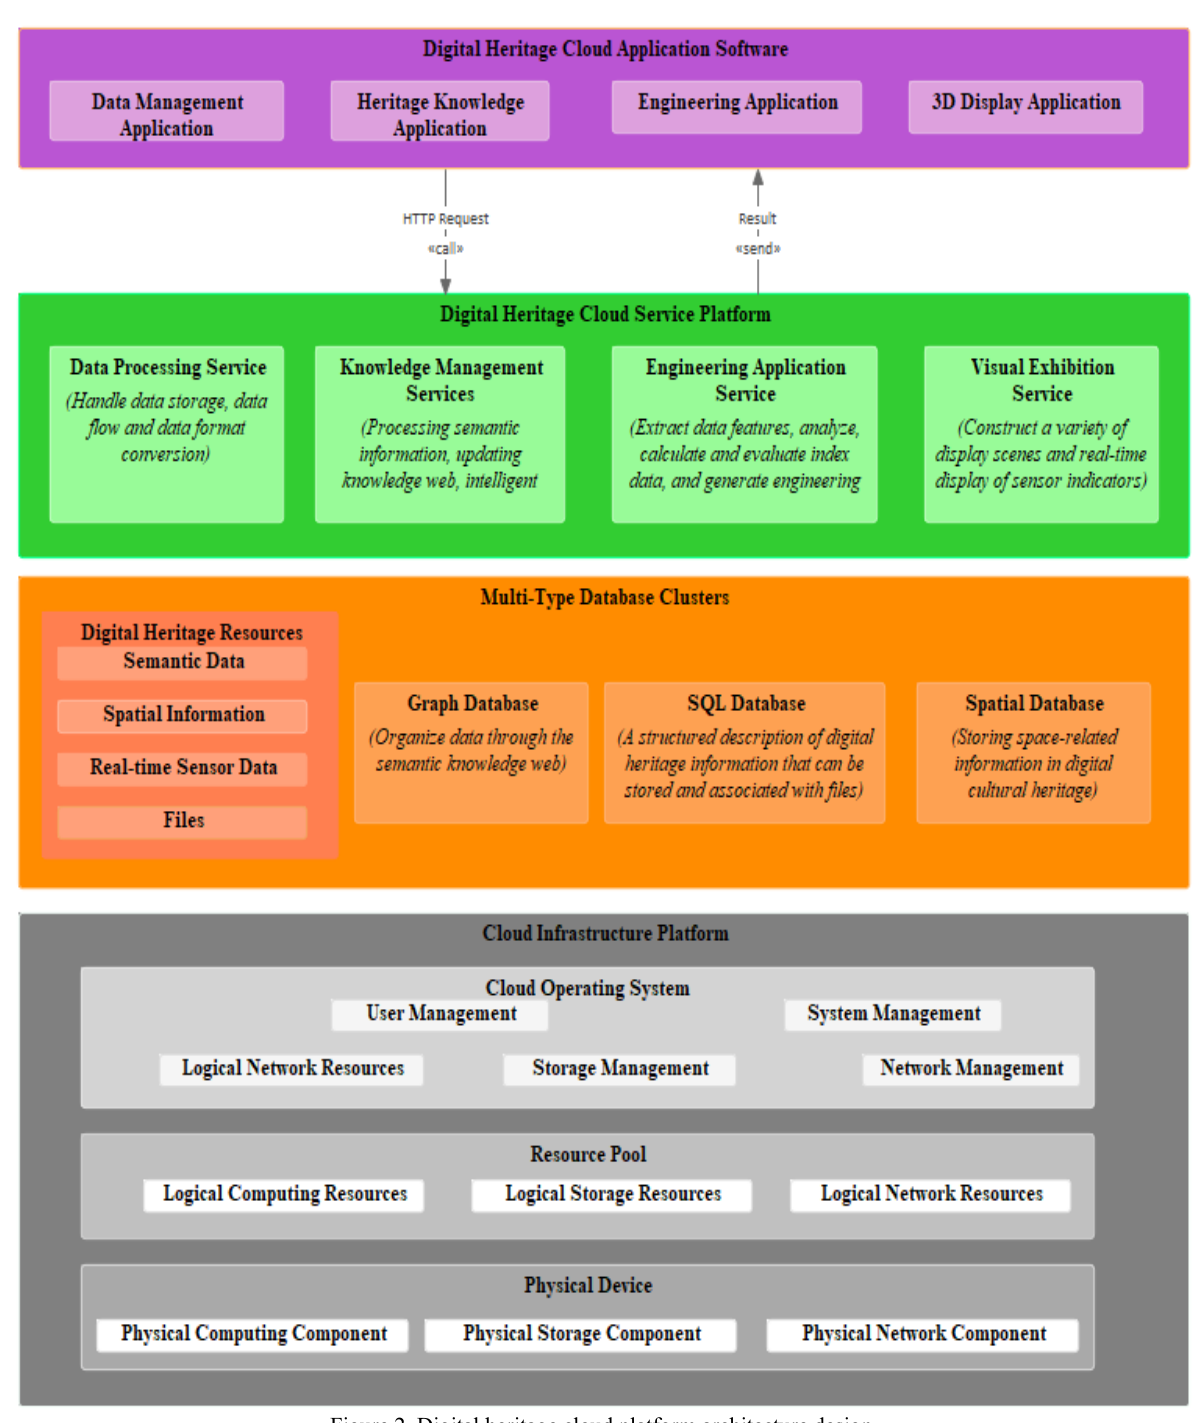
Figure 2. Digital heritage cloud platform architecture